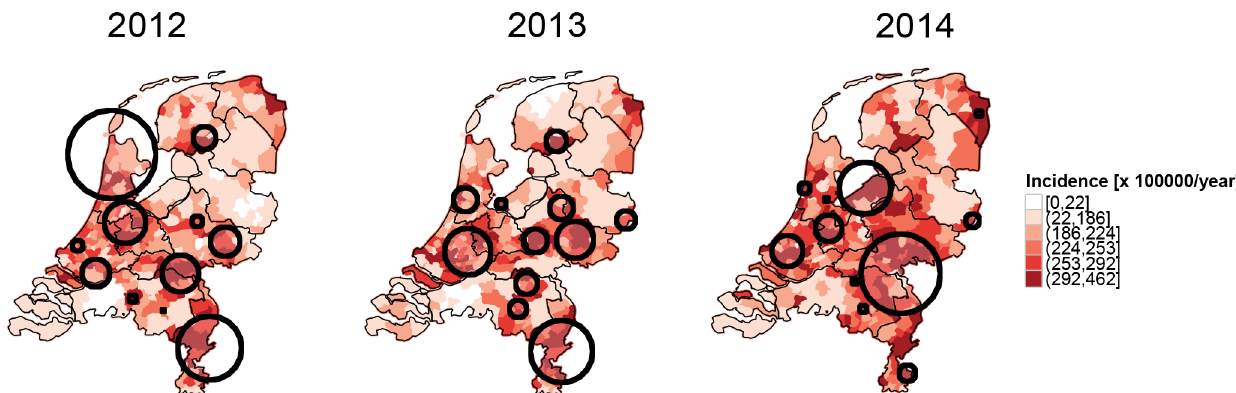
Fig 3. Maps of age adjusted incidence of unspecified pneumonia cases at municipality level for the years2012, 2013 and 2014. Black circles represent significantclusters (p < 0.05)identified whilst imposinga 10% upper limit and choosinga non-overlappingcriterion. The clusters in Sat Scan have been adjusted by taking age classes as covariatein the analysis. The incidenceintervals in the colorbar represent the quantilesof the pneumoniaincidencein 2014.